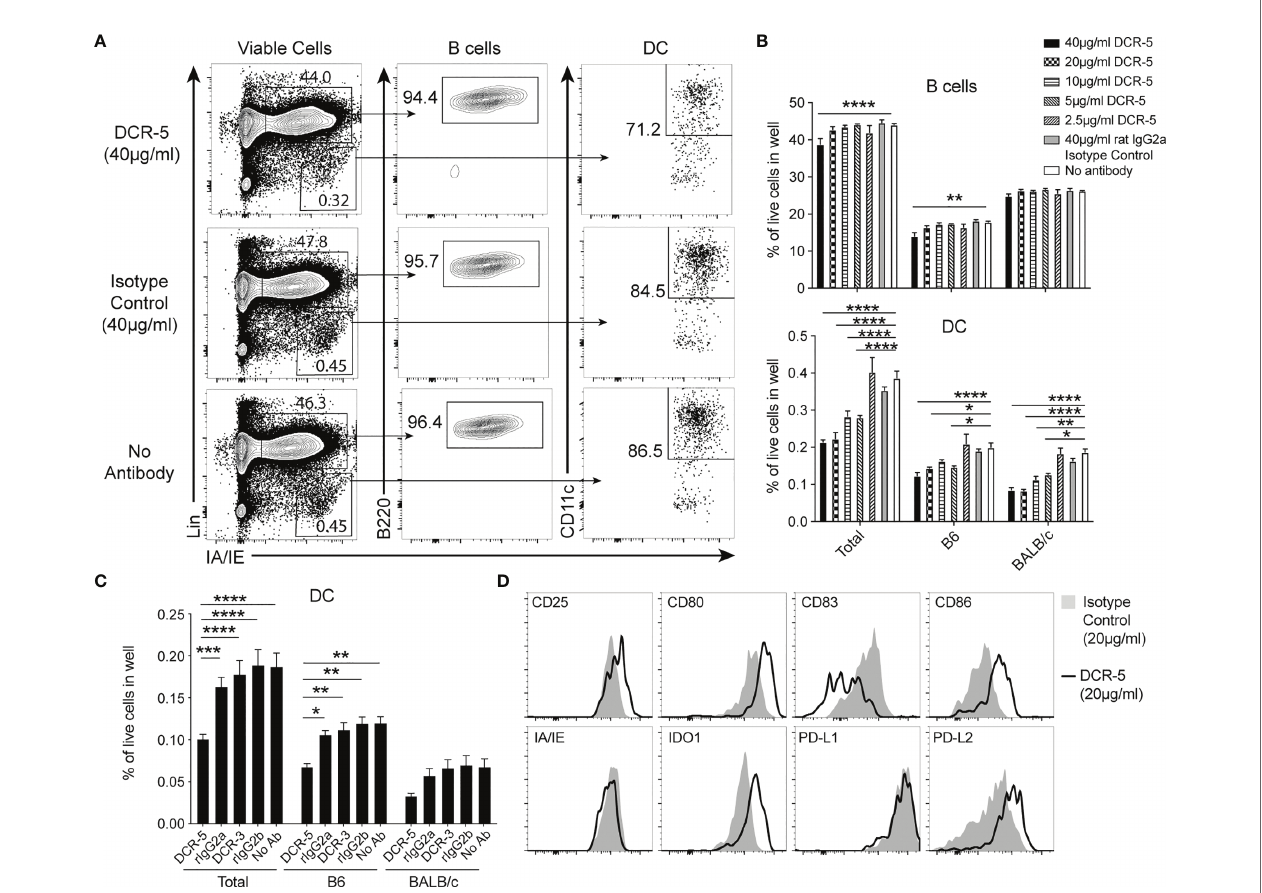
FIGURE 2 | DCR-5 depletes and alters DC phenotype in vitro . (A – D) B6 and BALB/c splenocytes were cocultured overnight in MLR at a 1:1 ratio with the indicated concentrations of DCR-5 or isotype control. Levels of DC and B cells per well were determined by fl ow cytometry. (A) Representative plots showing total DC and B cells in speci fi ed groups and (B) mean levels of total, B6 (H-2Kd − ) and BALB/c (H-2Kd + ) derived cells from triplicate wells. Statistical comparisons to no antibody group by 2- way ANOVA. (C) Mean percentage of DC in 12 wells from 3 experiments treated with no antibody or 10 µg/ml DCR-5, DCR-3 or isotype controls. Statistical comparisons by 2-way ANOVA. *p < 0.05, **p < 0.01, ***p < 0.001 and ****p < 0.0001. (D) One of three representative plots of designated surface and intracellular DCreg markers expressed by total DC after overnight MLR culture with 20 µg/ml DCR-5 or isotype